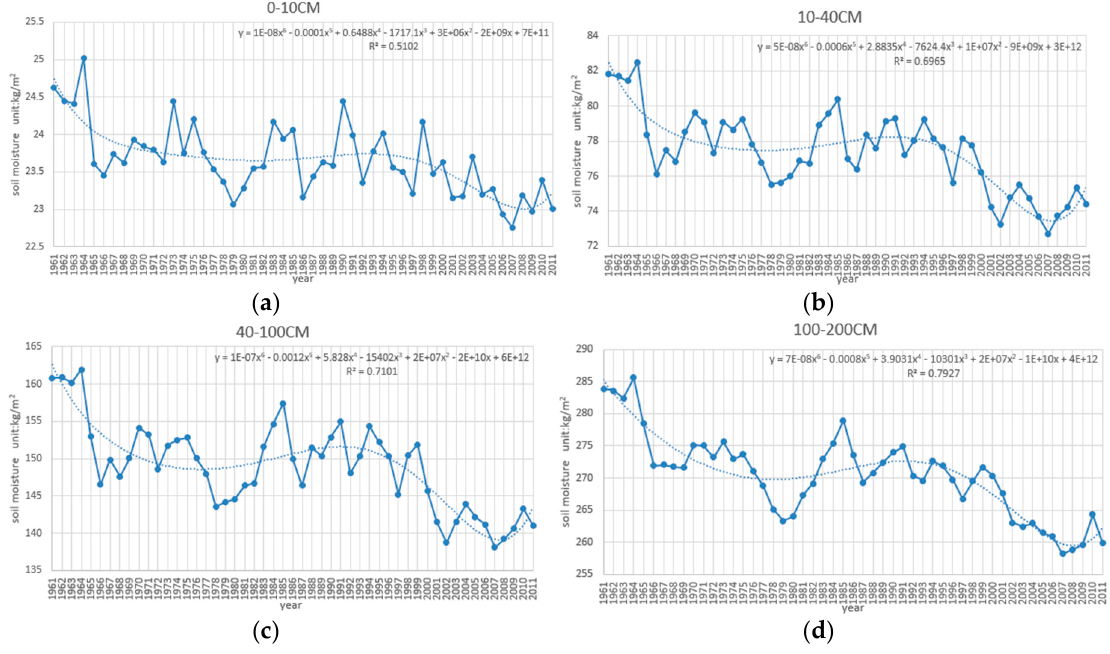
Figure 8. The average changes of soil moisture in different years in eastern China from 1961 to 2011: ( a) : 0–10 cm; ( b ) 10–40 cm; ( c ) 40–100 cm; ( d ) 100–200 cm.